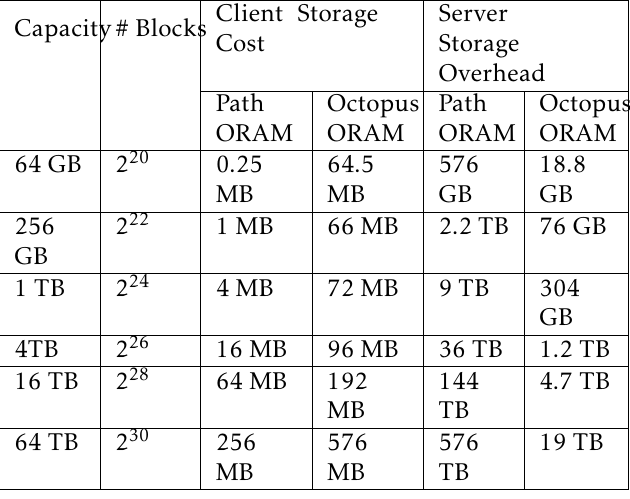
Table 3. Comparing Storage Efficiency between Octopus ORAM (with single server) and Path ORAM Capacity# Blocks